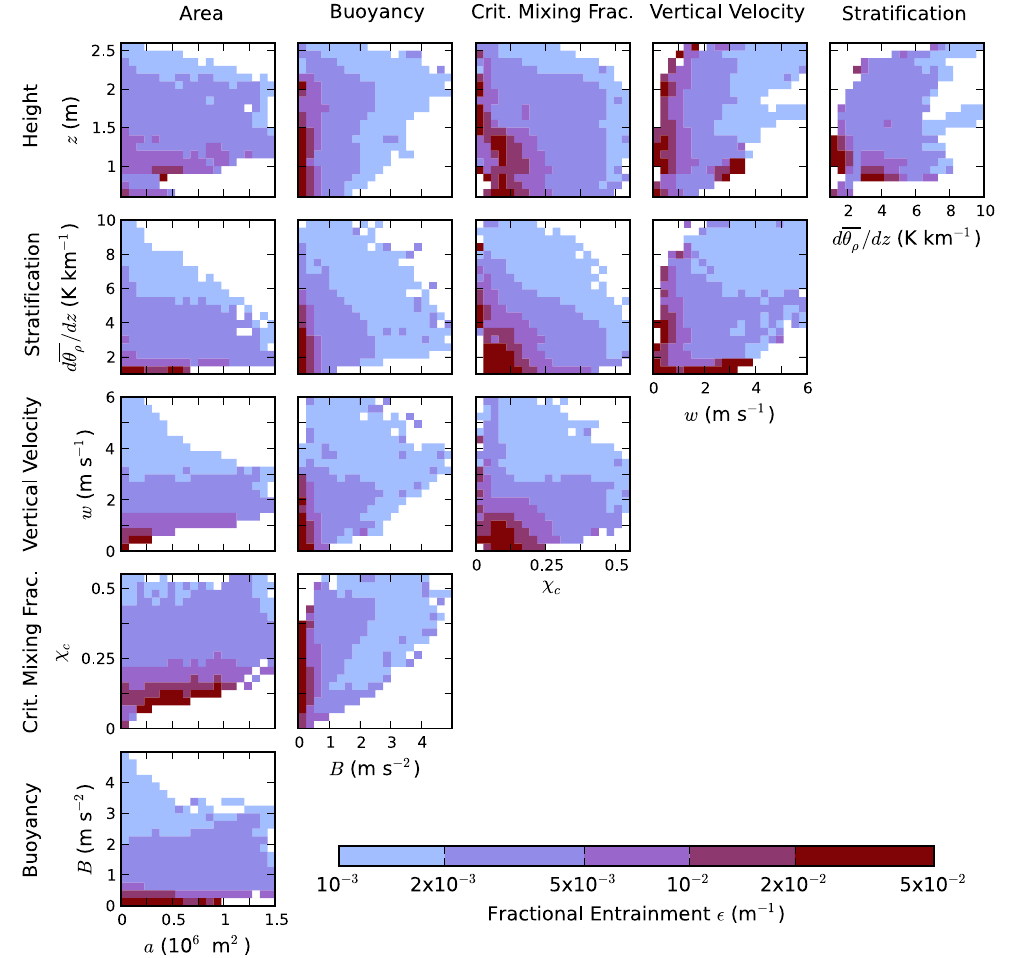
Fig. 6. Mean values of log 10 ((cid:15)) for each bin of joint probability density functions of various cloud core properties for individual clouds in the combined BOMEX and ARM LES output. The y axis of each row shows height, environmental stratification, critical mixing fraction, buoyancy, and vertical velocity (from top to bottom), and the x axis of each column shows cross-sectional area, vertical velocity, buoyancy, critical mixing fraction, and environmental stratification (from left to